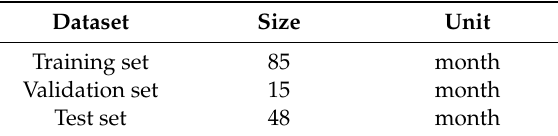
Table 3. Dataset partition for machine